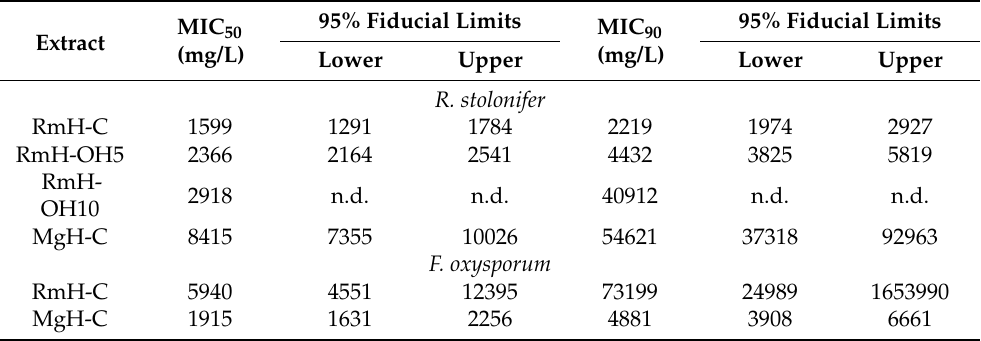
Table 7. Minimum inhibitory concentrations (MICs) of R. microphylla (Rm) and M. geometrizans (Mg) fruit extracts causing a reduction of 50 and 90% of mycelia growth of R. stolonifer and F. oxysporum . 95% Fiducial Limits MIC 95% Fiducial Limits MIC 50 90 Extract (mg/L) (mg/L) Lower Upper Lower Upper R.